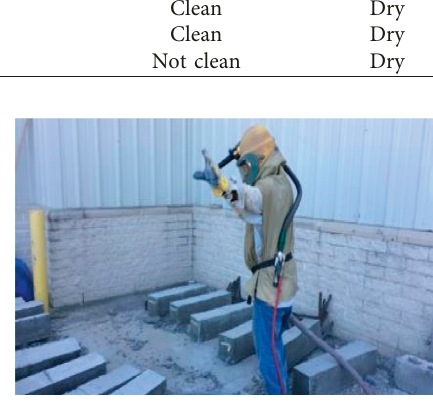
Figure 4: Sandblasting of beams.